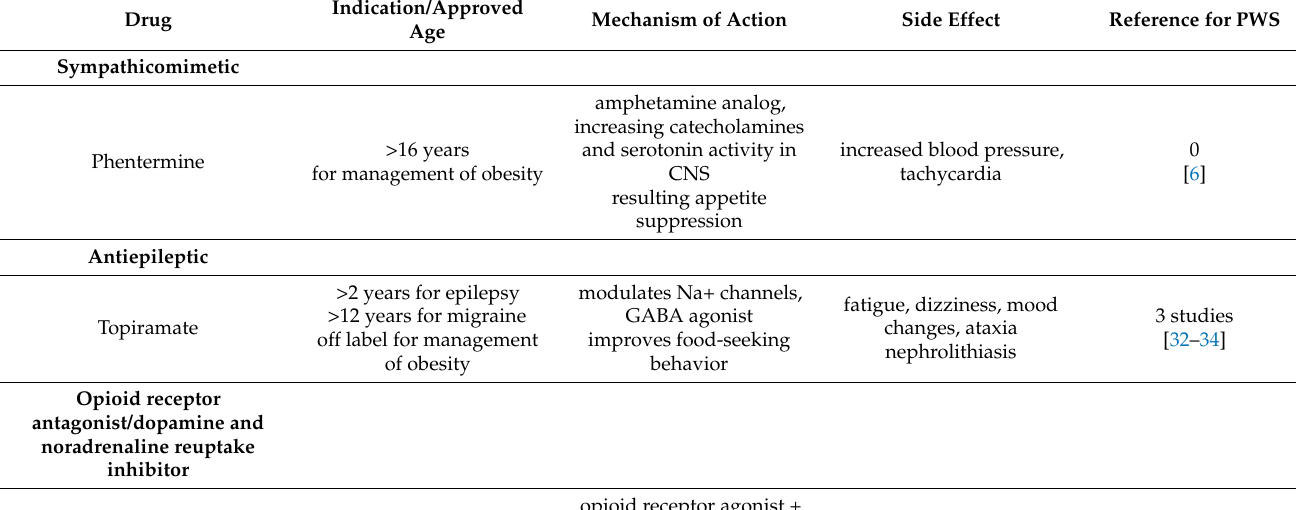
Table 1. Medication for the management of hyperphagia and obesity in